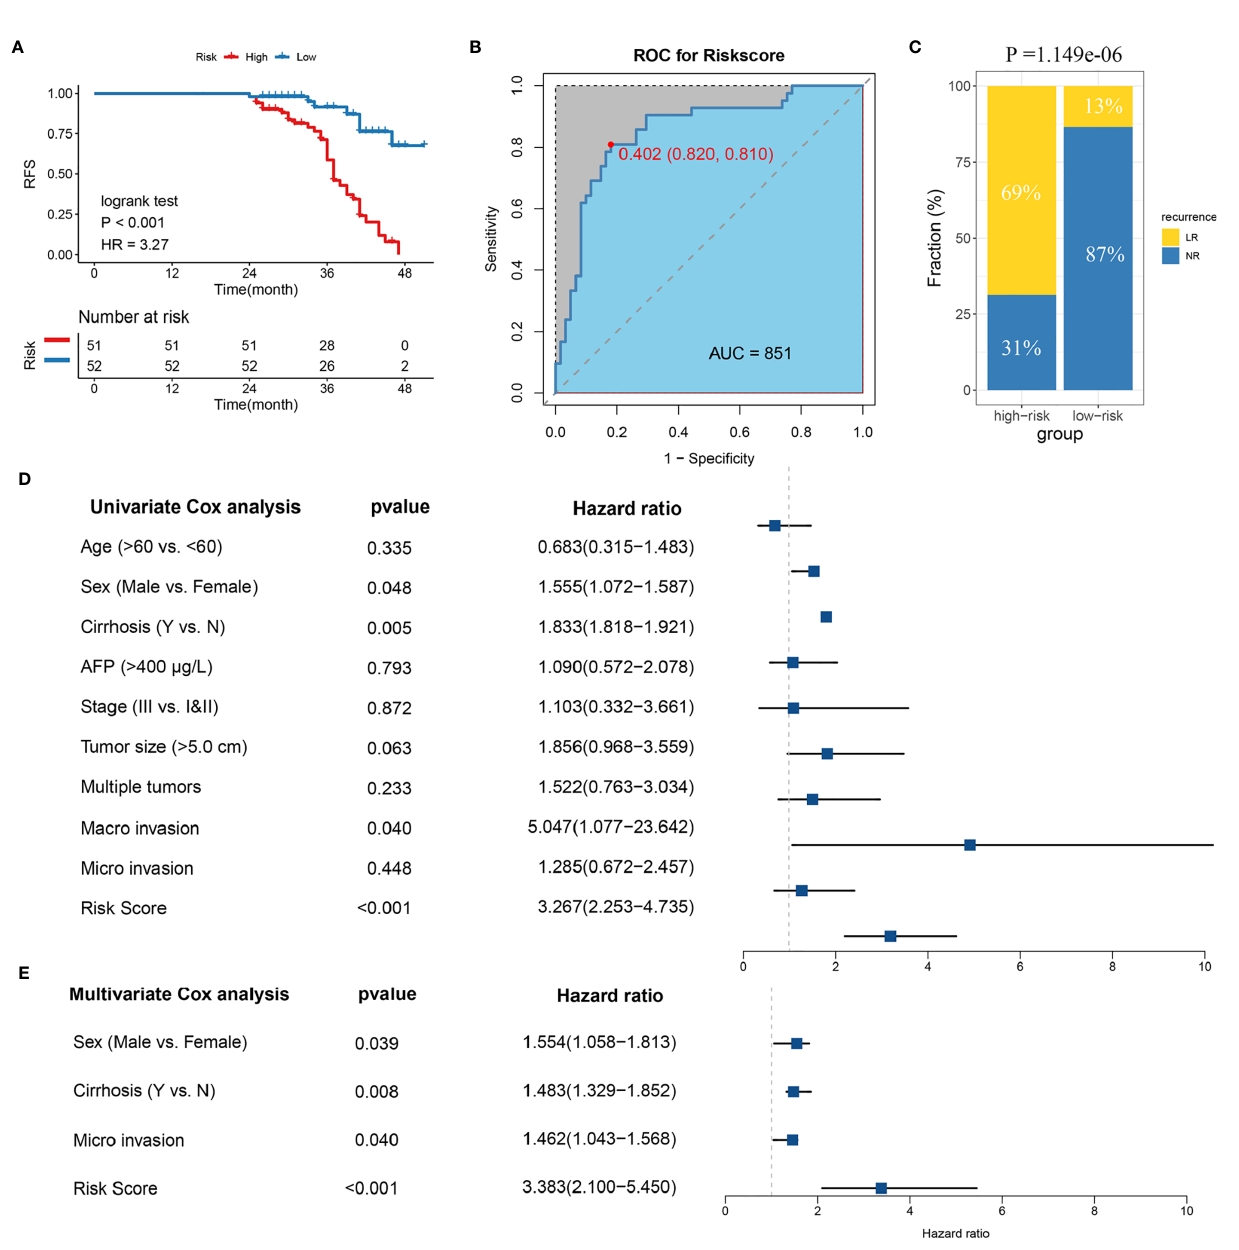
FIGURE 3 | Validation of the model in clinical in-house cohort. (A) Kaplan-Meier curves of RFS according to LR-related model. (B) ROC analysis for predicting LR. (C) Comparison of LR rates between the high- and low-risk groups. (D) Univariate Cox regression analysis of risk score. (E) Multivariate Cox regression analysis of risk